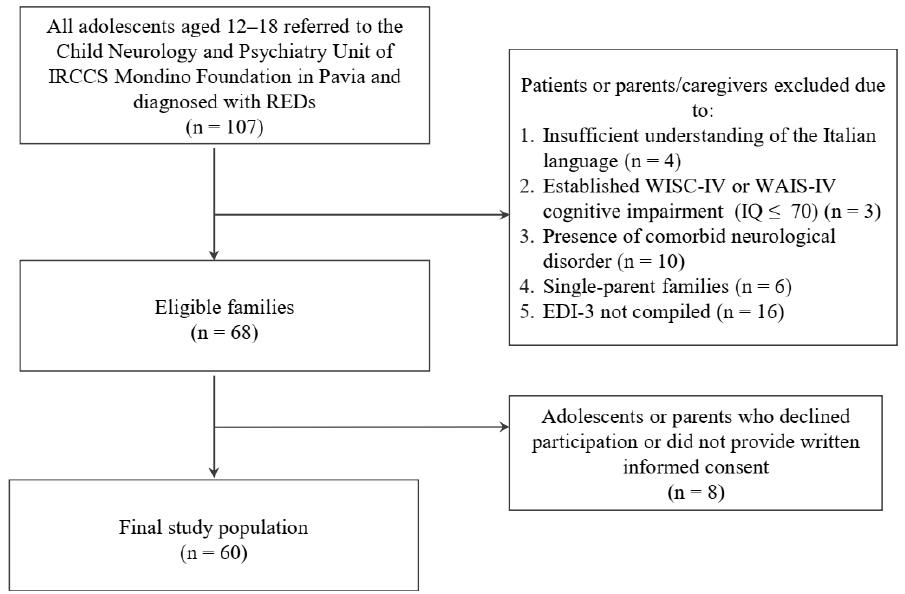
Figure 1. Study population flowchart.